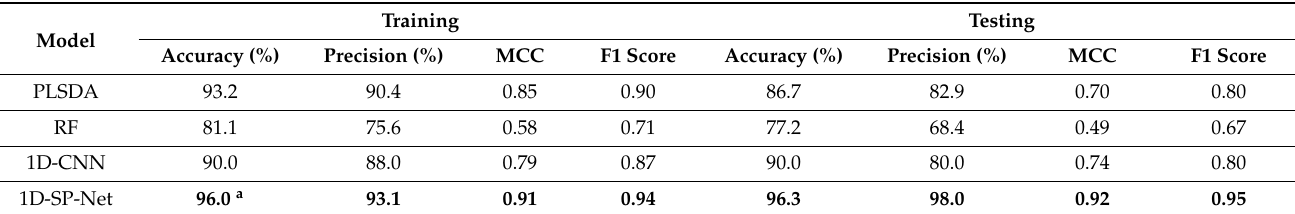
Table 2. Comparison of predictive performance for PLSDA, RF, 1D-CNN, and 1D-SP-Net models by accuracy, precision, MCC, and F1 score metrics.